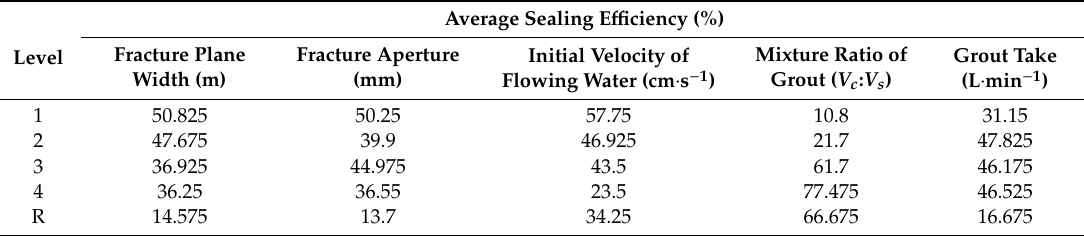
Table 3. Range analysis for main e ff ects on sealing e ffi ciency.